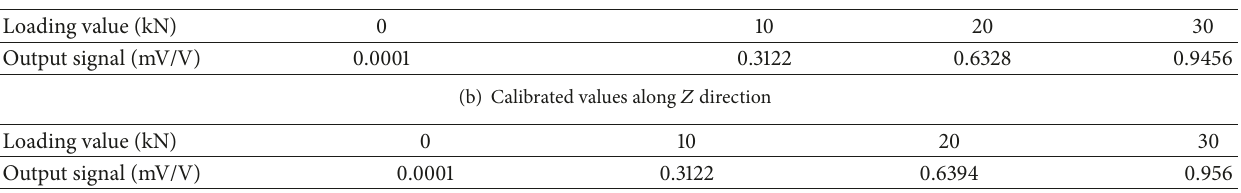
Table 7: Calibrated values of sensor output corresponding to forces acting on guiding support plate pin shaft along the 𝑌 and 𝑍 directions. (a) Calibrated values along 𝑌